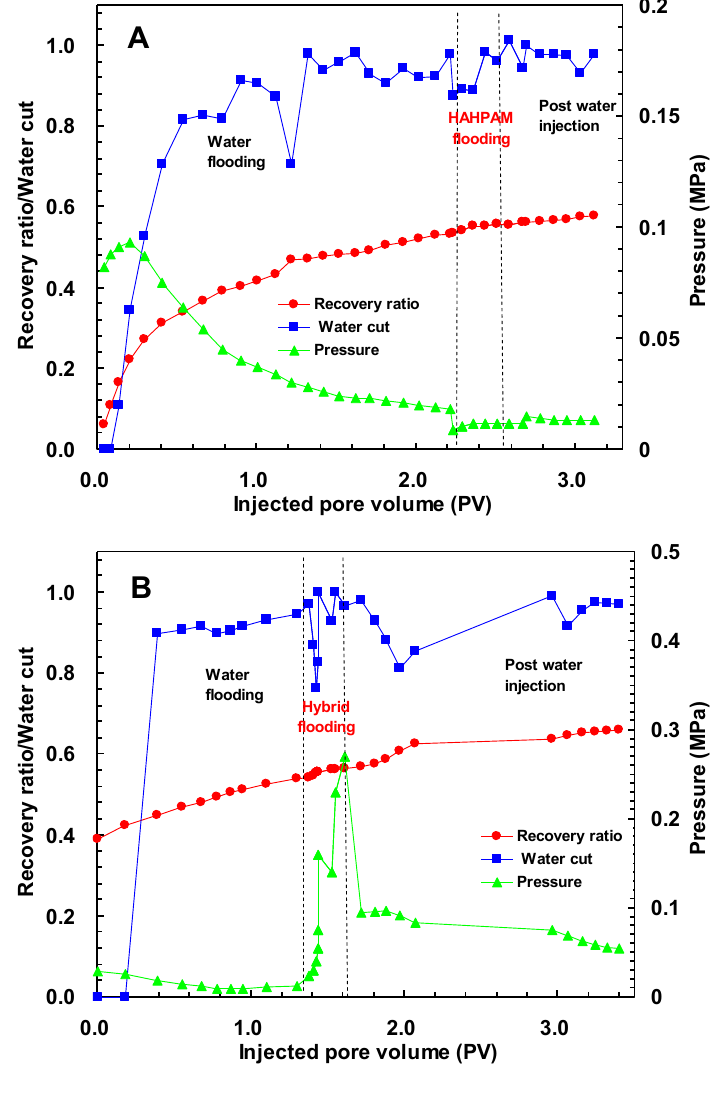
Figure 7. Recovery factor, water cut and flooding pressure plotted as a function of injected volume of the samples: ( A ) 0.5% HAHPAM and ( B ) 0.5% HAHPAM/0.5% silica hybrid (TDS = 32,868 mg∙L −1 , [Ca 2+ ] + [Mg 2+ ] = 873 mg∙L −1 ; T = 85 °C; injected volume = 30% PV; injected rate = 0.23 mL∙min −1